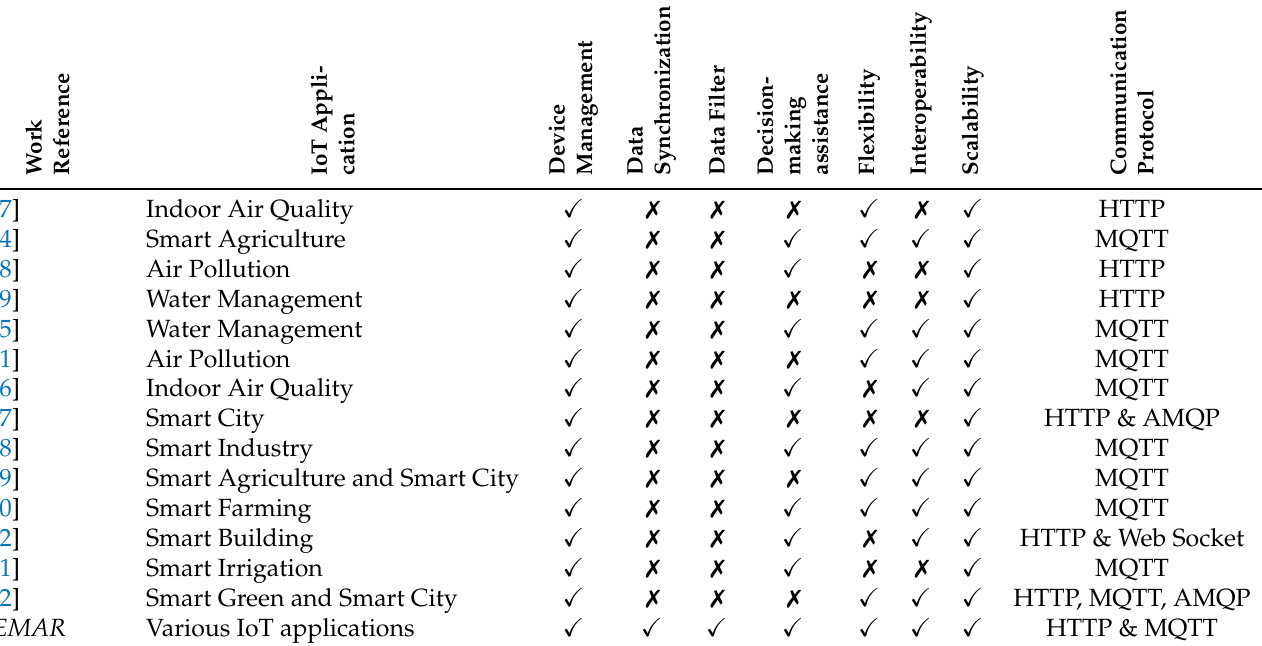
Table 6. State-of-the-art comparison between the existing related studies and the proposed